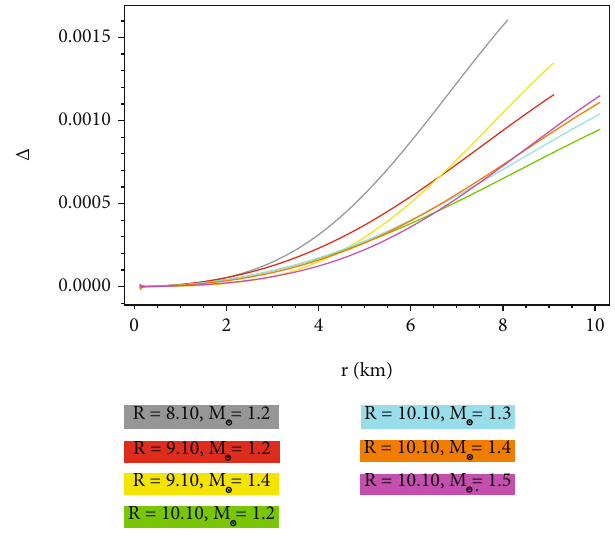
Figure 5: Behavior of Δ